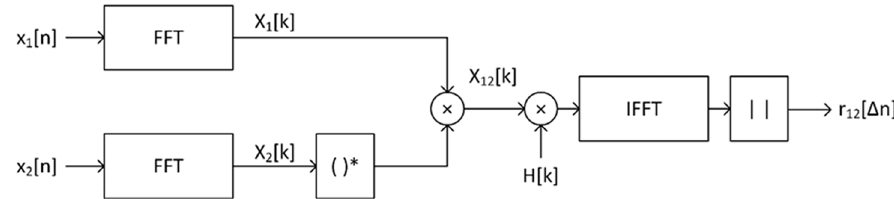
Figure 14. Scheme for computing a generalized cross ‐ correlation function.